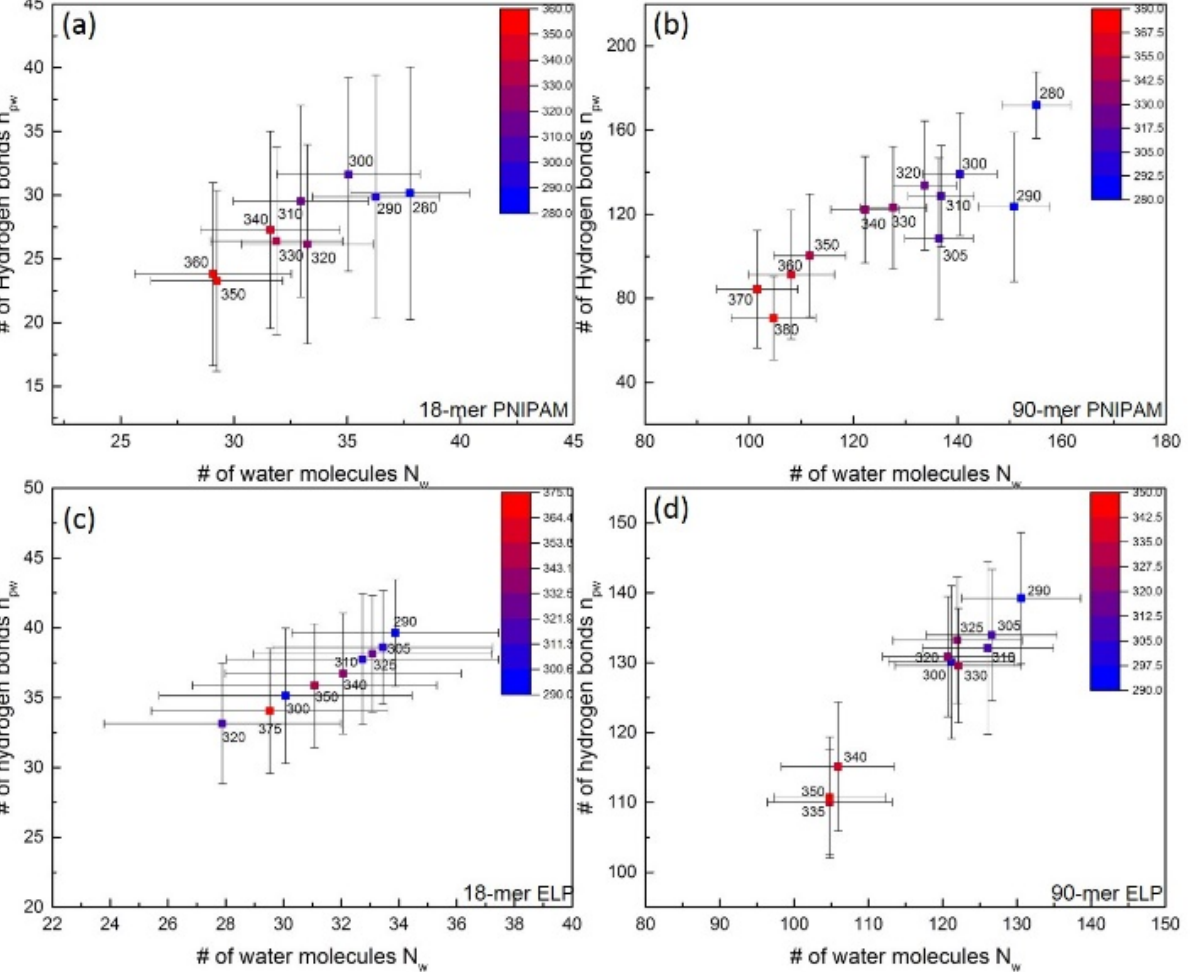
Figure 3. Number of hydrogen bonds between polymer and water (n pw ) and number of water molecules (N w ) within first hydration shell of hydrophilic group of polymers as a function of temperatures. ( a , b ) show the n pw and N w correlation of 18-mer and 90-mer of PNIPAM, respectively. ( c , d ) give the relationship of n pw and N w for 18-mer (GVG(VPGVG) 3 ) and 90-mer ((VPGVG) 18 ) of ELP,